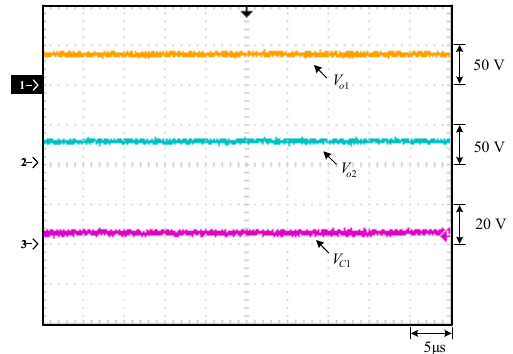
Figure 20. Measured waveforms under a difference in LED count between the two LED strings: (1) V o 1 ; (2) V o 2 ; (3) V C 1 .